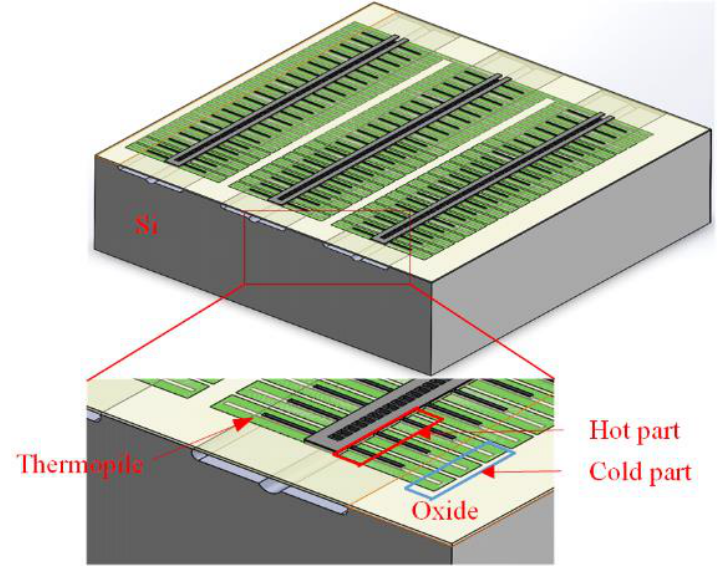
Figure 1. Thermoelectric microgenerator structure.